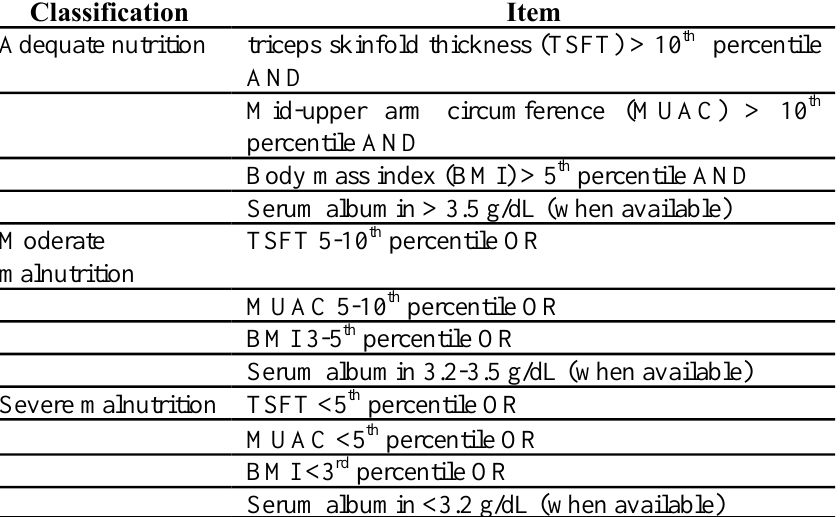
Table 3. Classification of malnutrition. Adapted from Pribnow et al. 14